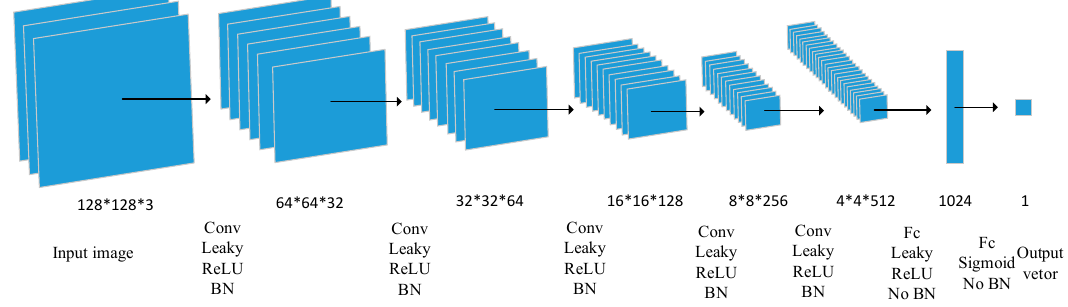
Figure 5. Convolution network structure of the descriminator.